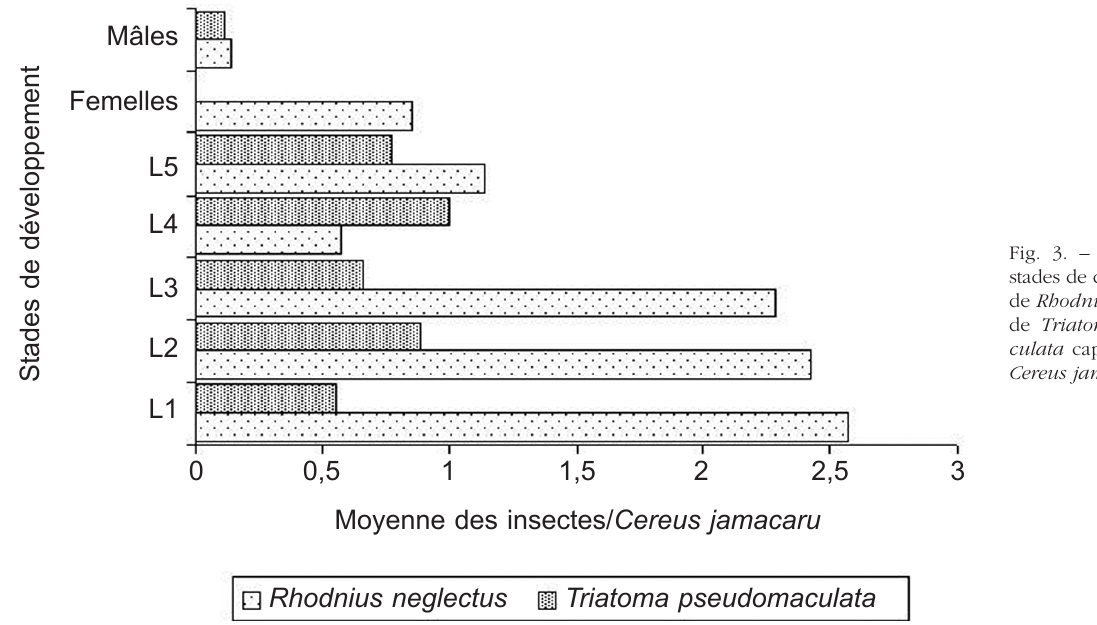
(figure 3). Pour R. neglectus , l’abondance des premiers